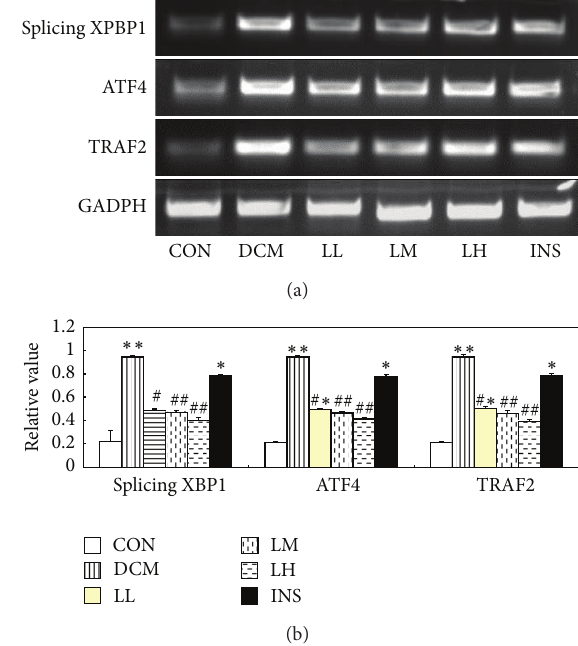
Figure 4: Effects of LIRA on the activation of caspase-12 in the DCMandCON.(a)Westernblotwasperformedusingeachrelevant antibody. 𝛽 -actin was shown as a loading control. (b) Statistical analysis. Data were shown as mean ± S.D. ∗ 𝑃 < 0.05 and ∗∗ 𝑃 < 0.01 versus CON rats, # 𝑃 < 0.05 versus DCM rats.